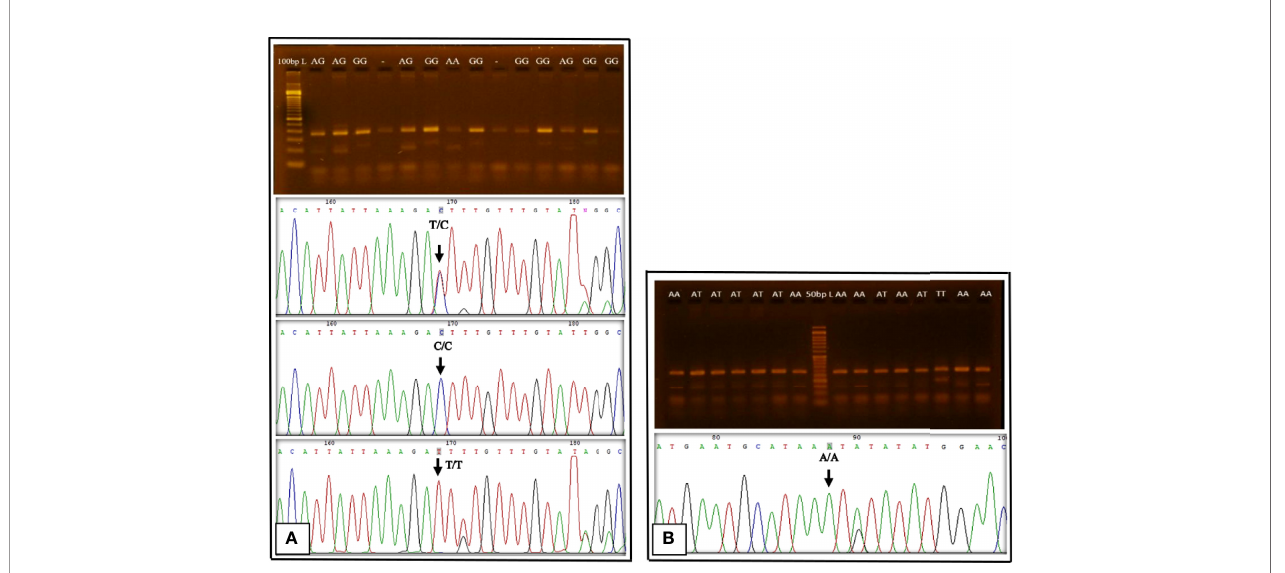
FIGURE 2 | Gel electrophoresis pattern of ARMS-PCR and Sequence chromatographs showing rs3931020 and rs13144478 variants. (A) : rs3931020, DNA ladder = 100 base pairs (bp), PCR product size for A allele =192 bp, G allele = 229 bp, two outer primers = 368 bp; Sequence chromatograph of rs3931020 is reverse complement. (B) : rs13144478, DNA ladder = 50 bp, PCR product size for A allele =148 bp, T allele = 189 bp, two outer primers = 282 bp.